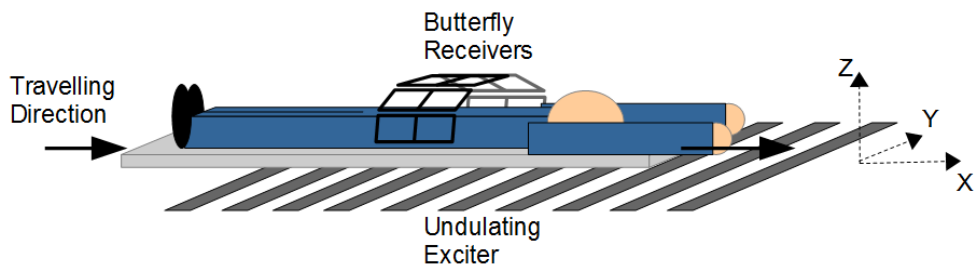
Figure 15. Schematic of a longitudinal scanner setup with a person lying down. The undulator enhanced reconstructions promise more success for the interiors of living beings with a decreased SNR, i.e., 50 dB [12] instead of the practically apparent SNR of 60 dB (Figures 2 and 13) from the saline cuboid. Although many demanding tasks remain to be solved, the development of a quick and convenient 3D MIT is getting closer to being